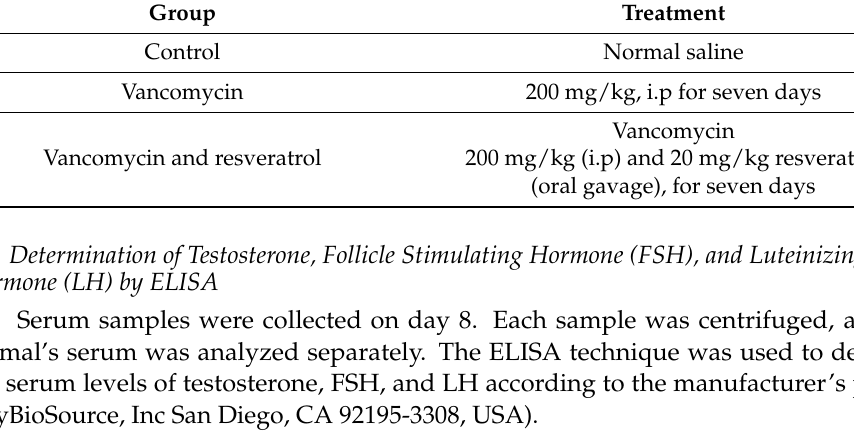
Table 1. Experimental groups for the resveratrol and vancomycin administration. Group Treatment Control Normal saline Vancomycin 200 mg/kg, i.p for seven days Vancomycin and resveratrol (oral gavage), for seven